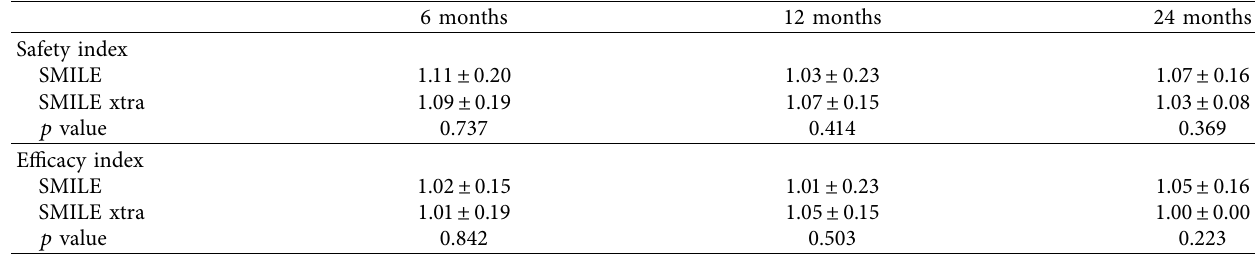
Table 2: The safety indices (postoperative CDVA/preoperative CDVA) and efficacy indices (postoperative UDVA/preoperative CDVA) of both groups at 6, 12, and 24 months.